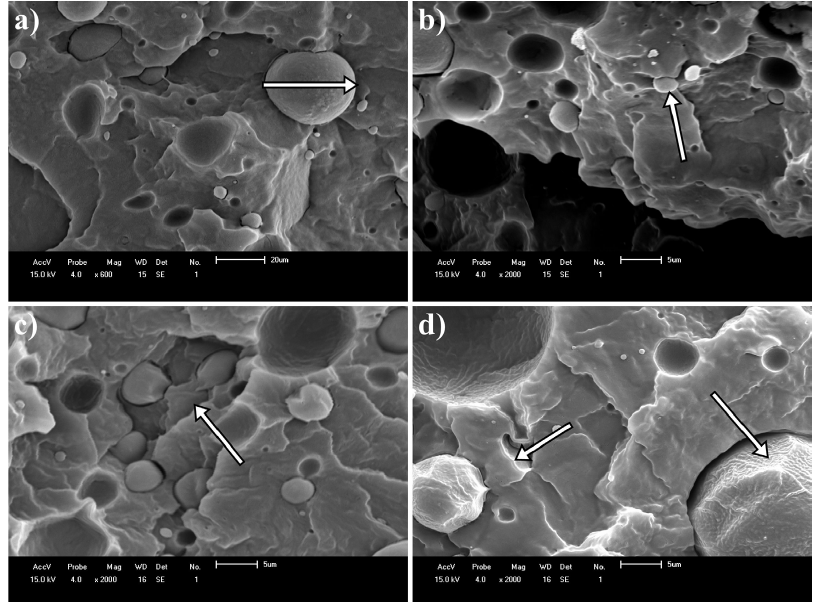
Figure 4. Micrographs of the blend with 1 reprocessing cycle (a), with 3 reprocessing cycles (b), with 5 reprocessing cycles (c) with 7 reprocessing cycles